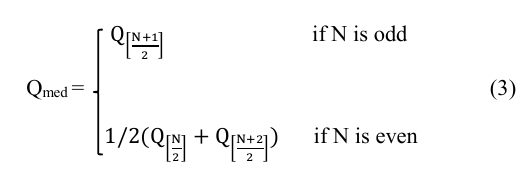
According to the figure 3 the results of the mean NDVI trend analysis using the least squares regression and the Theil-Sen approaches showed almost no-trend with a slope of